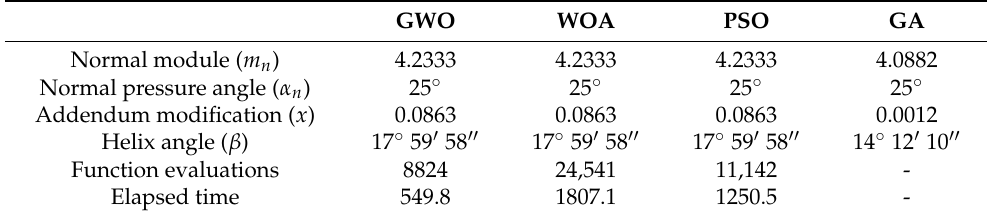
Table 9. Best solutions of the proposed algorithms for scenario II and relevant obtained input design parameters. GWO WOA PSO GA